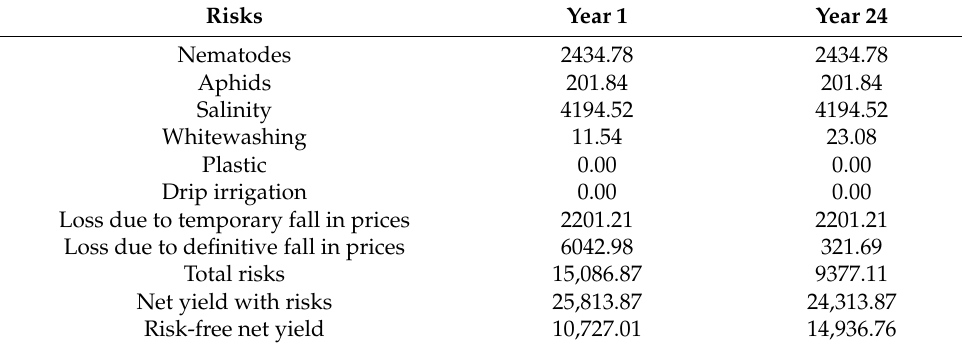
Table 10. Summary of risks considered.